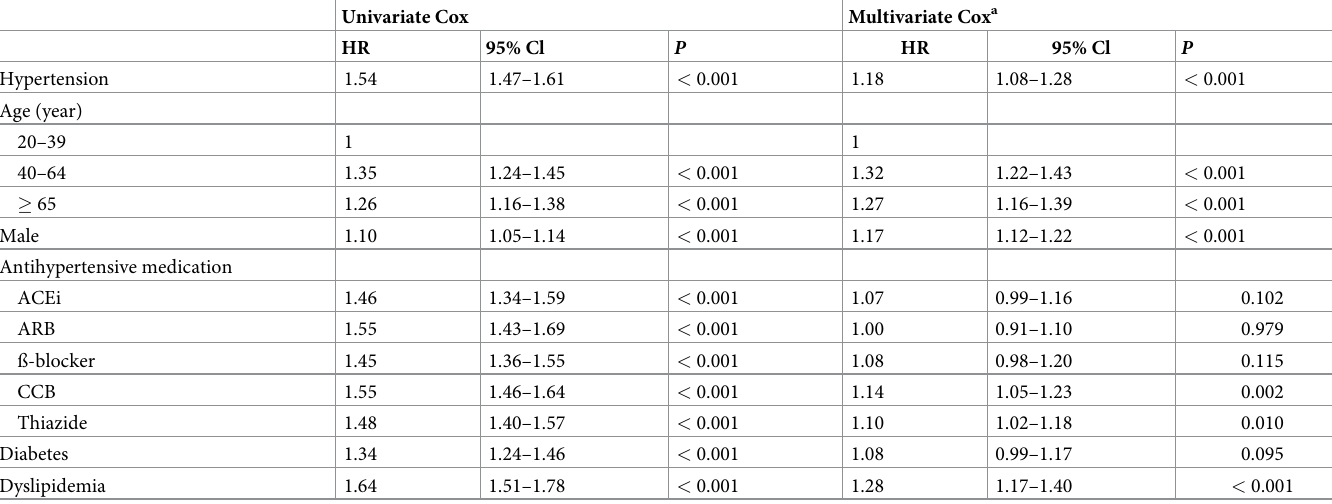
Table 2. Longitudinal association between hypertension and psoriasis incidence.